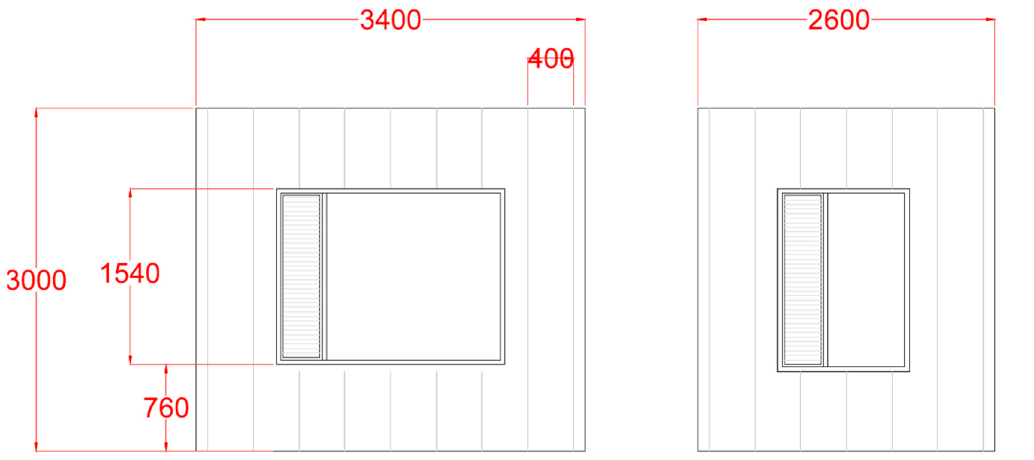
Figure 1. Panel designs for the façade of the demonstrator school